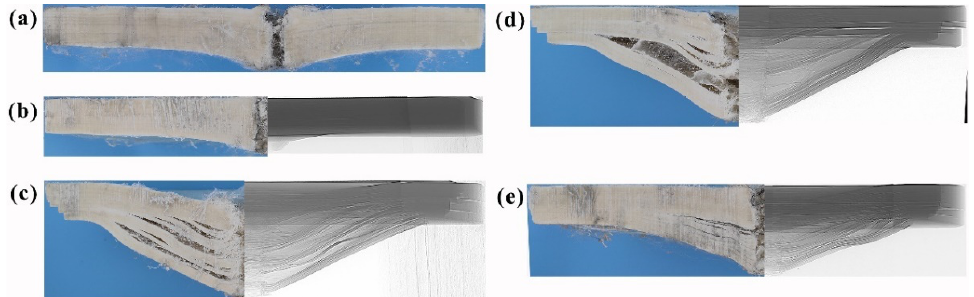
Figure 4. The deformation features of the UHMWPE laminate impacted various projectile nose shape. ( a – e ) were 60°, ogival, 120°, flat, and hemispherical nose shape projectile,